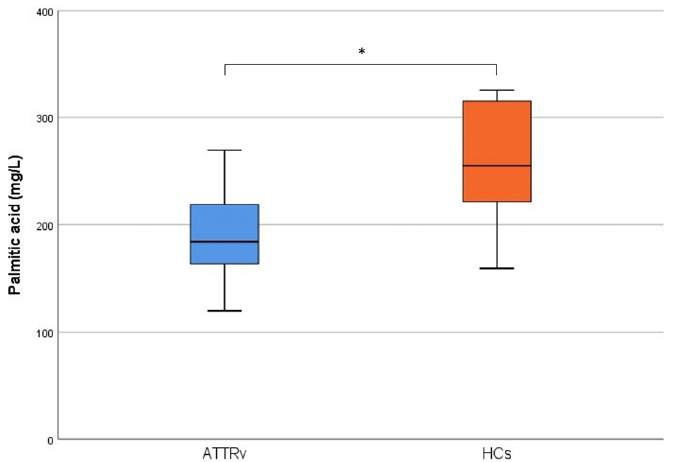
Figure 1. Palmitic acid levels in ATTRv patients and healthy controls, * refers to significant statistically difference ( p = 0.002).